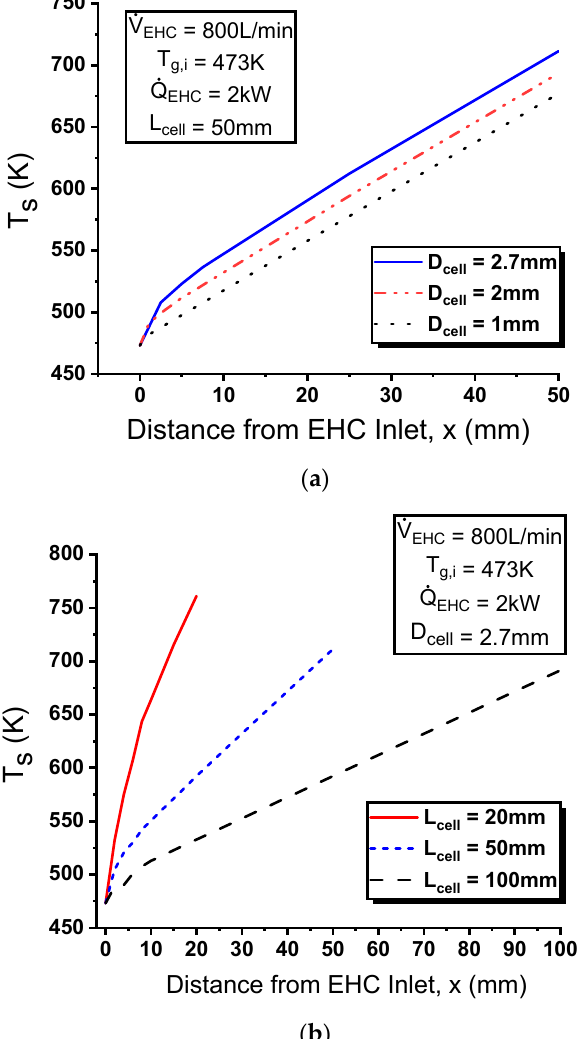
Figure 8. Effect of flow cell diameter ( D cell ) and length ( L cell ) on the surface temperature distribution in the EHC: ( a ) effect of D cell , ( b ) effect of L cell